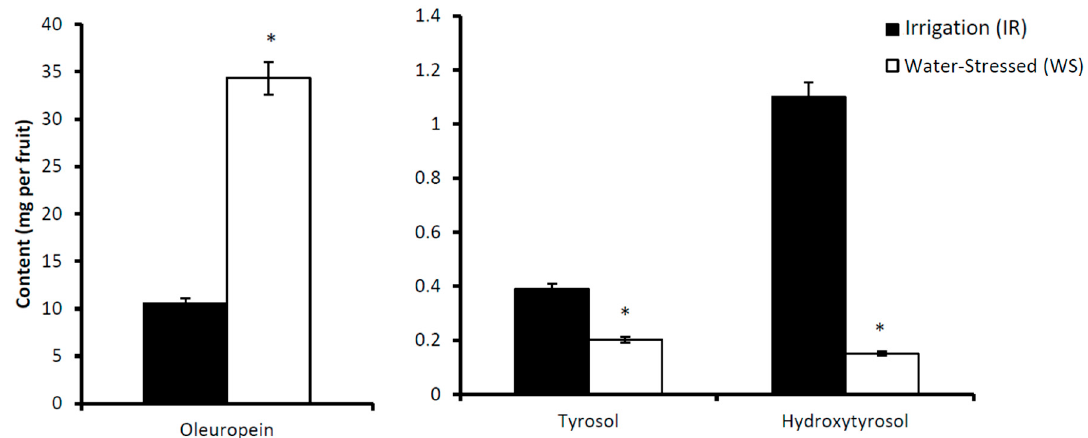
Figure 8. Content of phenolics (mg) of irrigated (IR) or water-stressed (WS) fruits of cv. Picual olive trees. The content of each phenol was calculated by multiplying the concentration, expressed as mg per g of fresh weight, by the fruit pulp weight. For comparisons between the irrigation and water stress conditions, * p < 0.05.